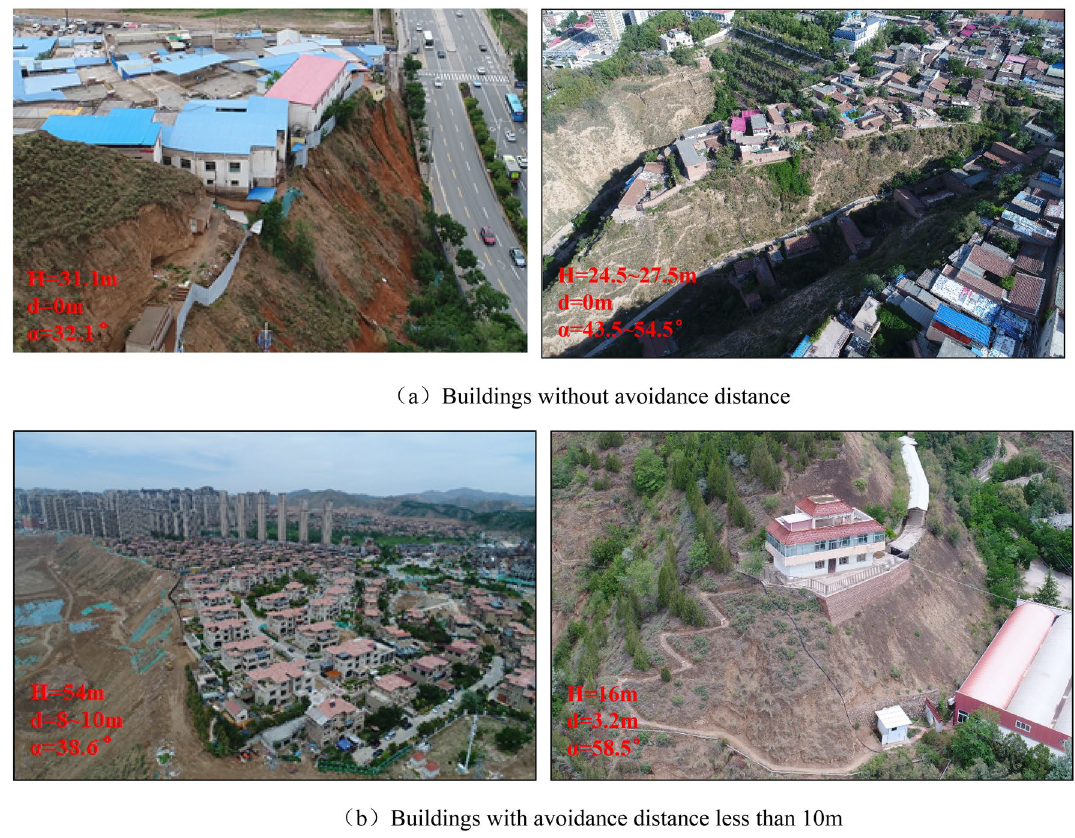
Figure 2. Typical buildings on the top of loess slope in the west of China.